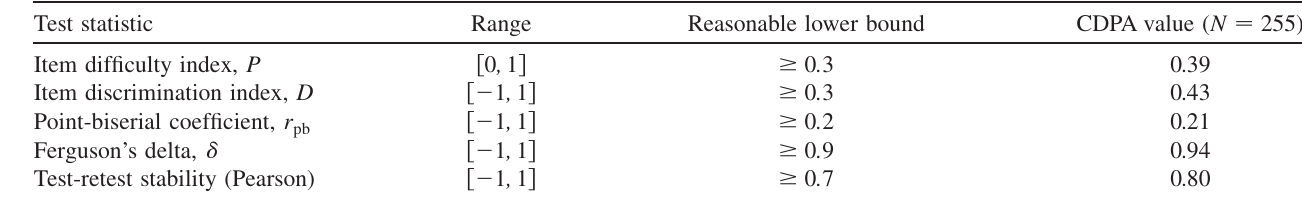
TABLE IV. Summary of statistical test results for the CDPA. Test statistic Range Reasonable lower